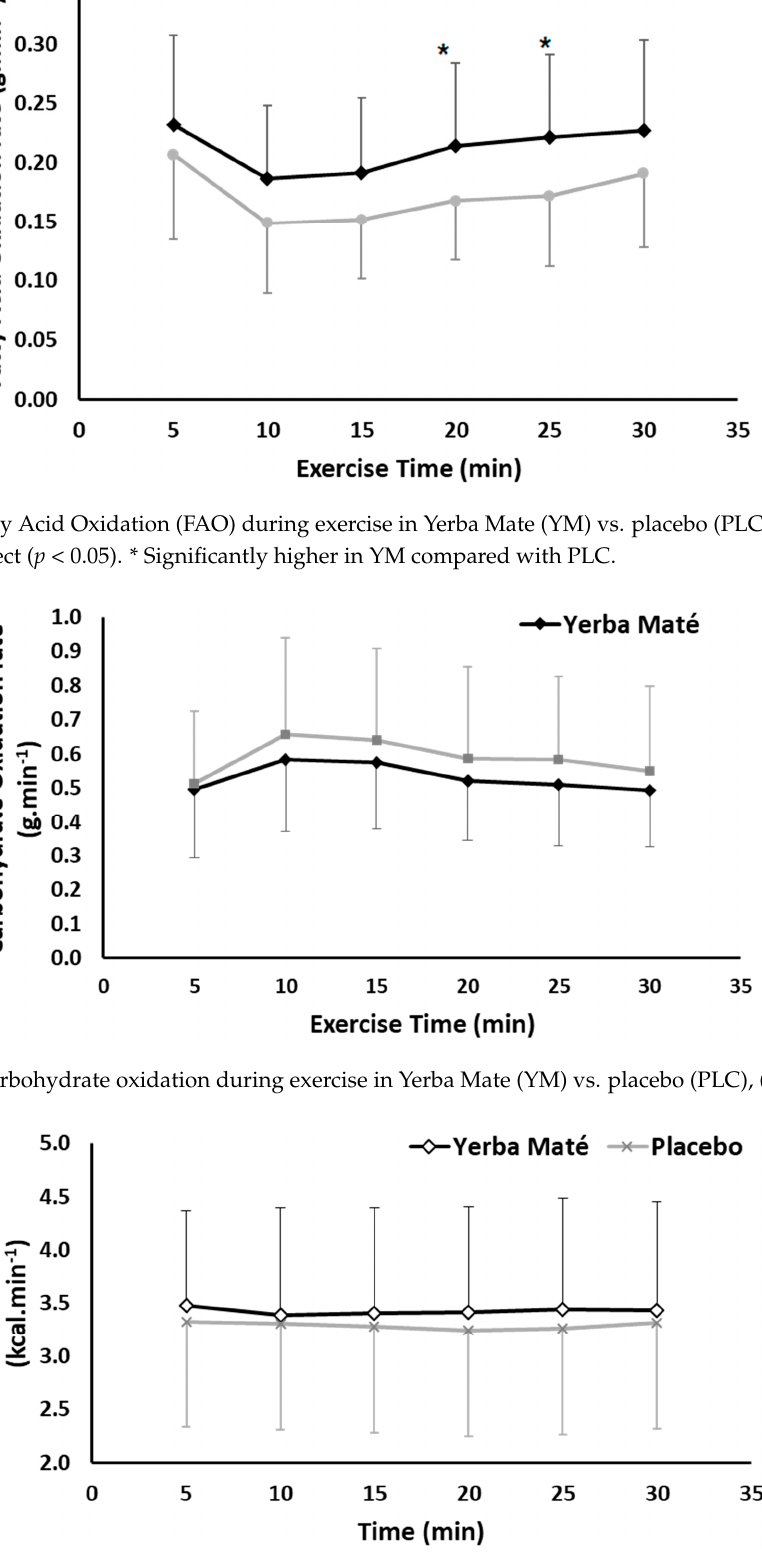
Figure 3. Total Energy expenditure during exercise in Yerba Mate (YM) vs. placebo (PLC).